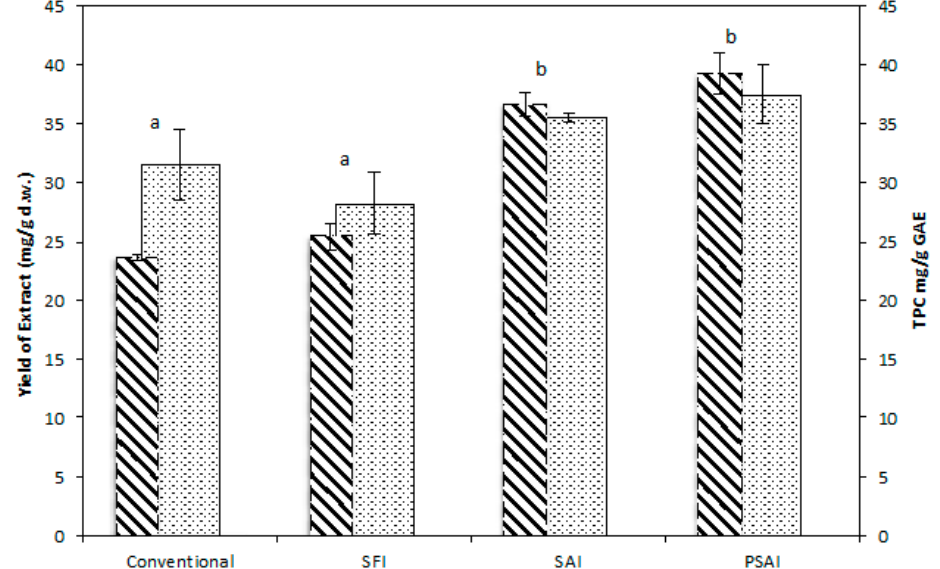
Figure 1. Comparison between total yield (mg / g d.w.) (lined bars) and total phenolic content (TPC) expressed as mg / g gallic acid equivalents (GAE) (dashed bars) obtained from a conventional extract and extracts obtained using the different pretreatments (solvent-free irradiation (SFI), solvent-assisted irradiation (SAI) and pressurized solvent-assisted irradiation (PSAI)). Lowercase letters (a,b) represent significant differences ( p < 0.05) between yield of extract and TPC.